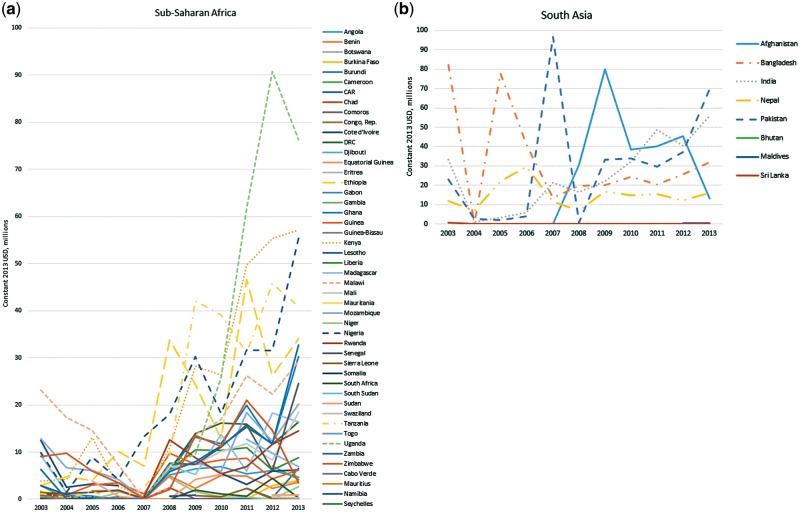
(a) ODA+ disbursements for family planning to recipient countries, Sub-Saharan Africa. (b) ODA+ disbursements for family planning to recipient countries, South Asia. (c) ODA+ disbursements for family planning to recipient countries, All other recipient countries